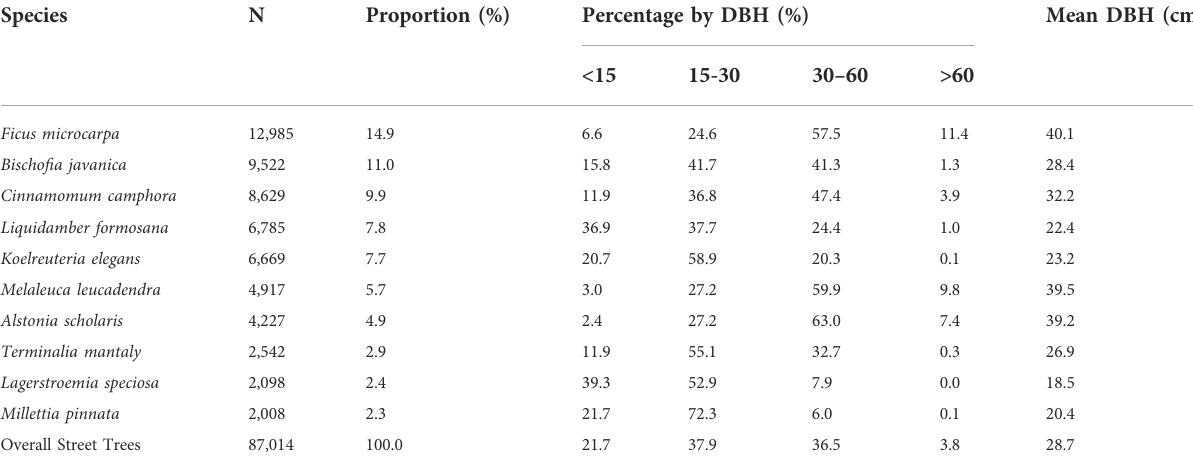
TABLE 1 Summary of the top 10 species of the Taipei street trees in quantity (N), population percentage (%), percentage by DBH classi fi cation, and mean DBH (cm). Species